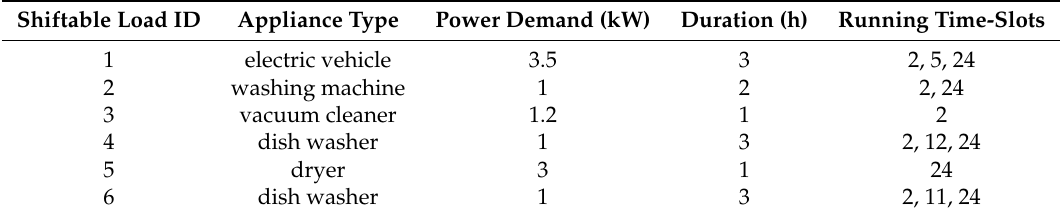
Table 5. Part of the obtained optimal strategy of Customer